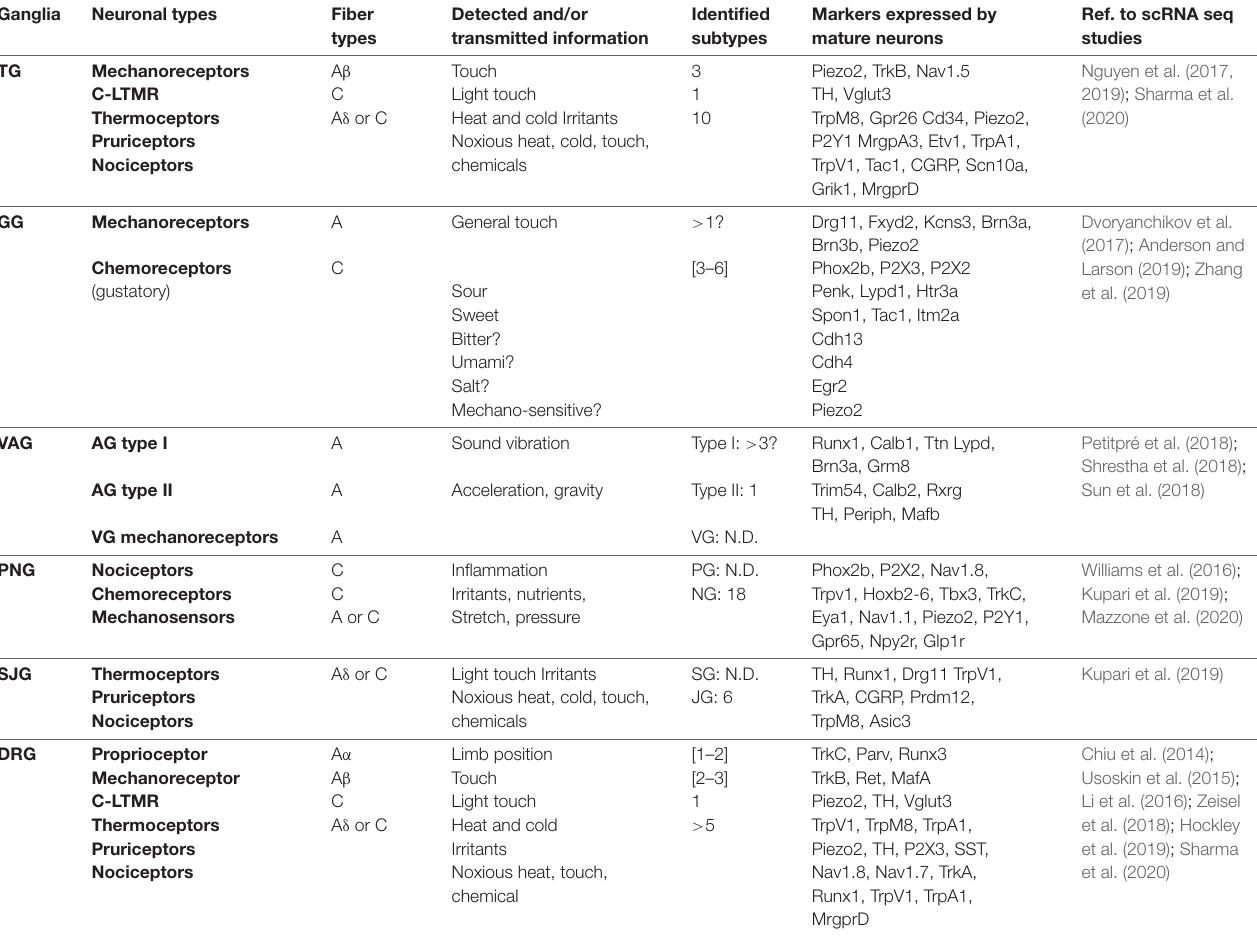
TABLE 1 | Neuronal diversity and function of PNS sensory ganglia in adult mouse.